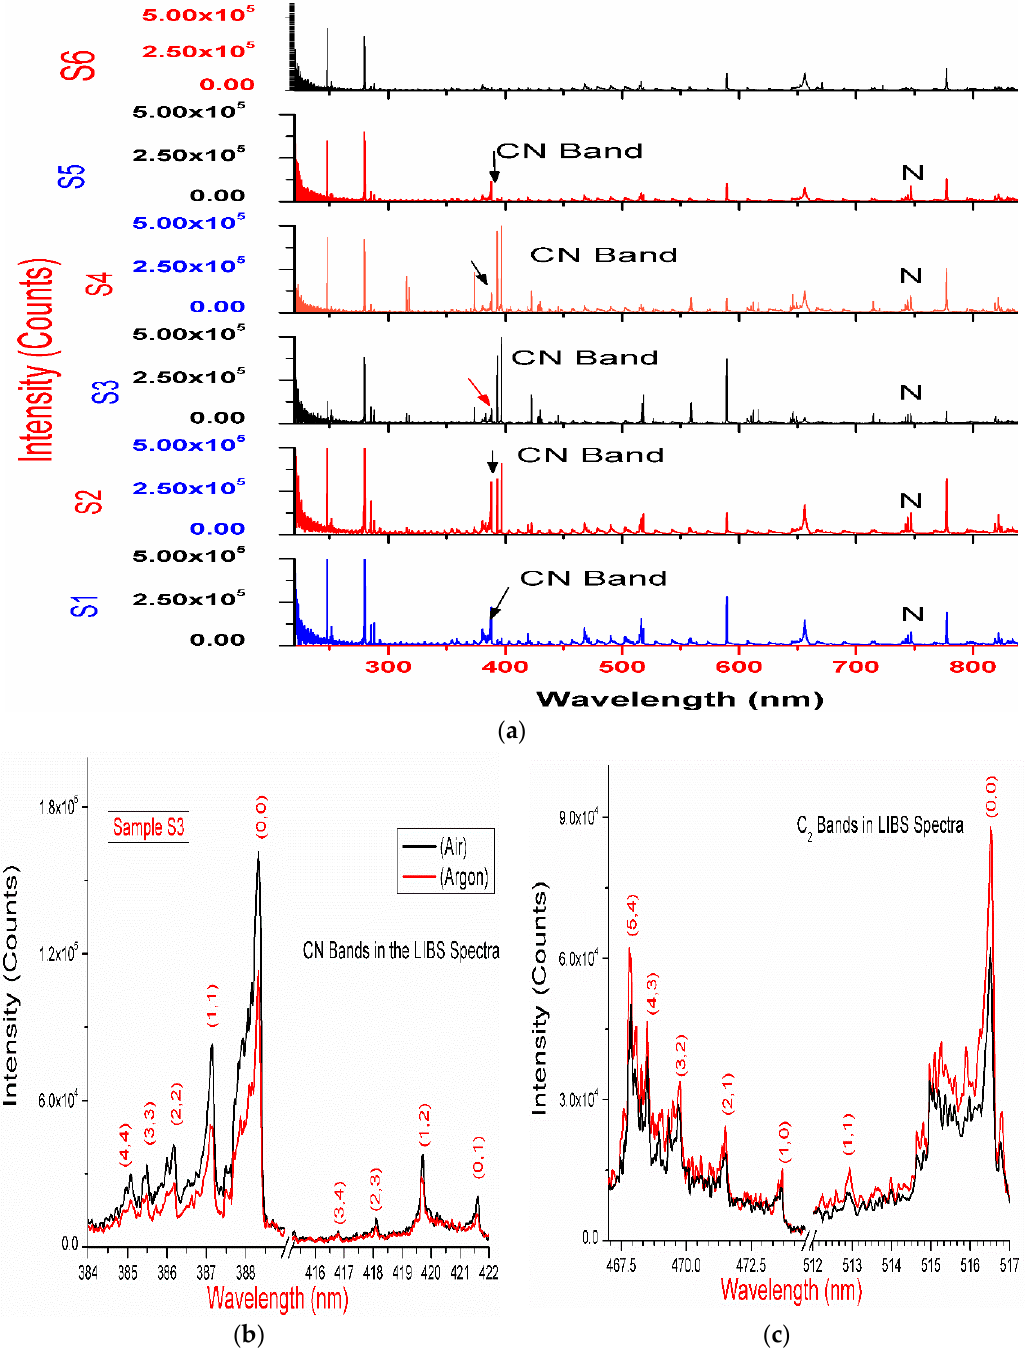
Figure 1. ( a ) The laser-induced breakdown spectroscopy (LIBS) spectra of drugs S1–S6 recorded in ambient atmosphere, 240–850 nm; ( b , c ) LIBS spectra (average of 10 spectra of each spectra having 50 accumulations) of sample S3 recorded in argon and ambient atmosphere.